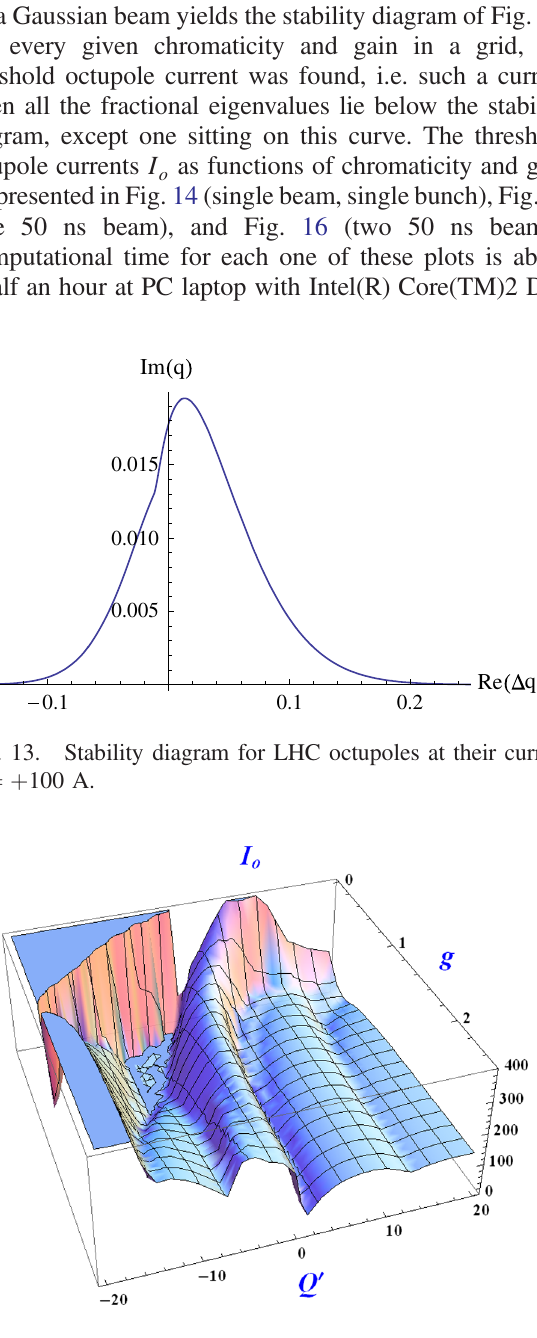
FIG. 14. Threshold octupole current [A] at positive polarity, for a single nominal bunch in the LHC and doubled nominal